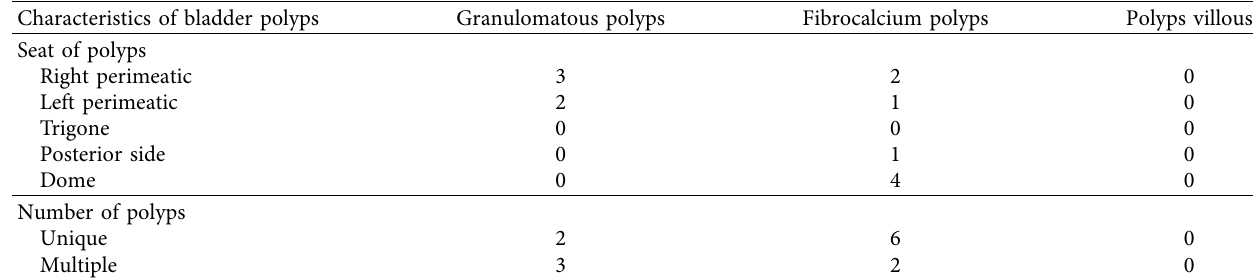
Table 2: Distribution of polyps according to their